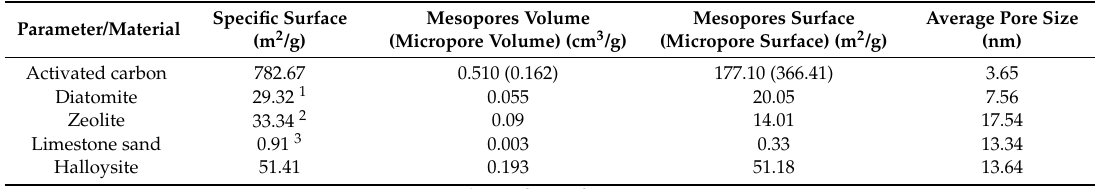
Table 1. Surface characteristics of the reactive